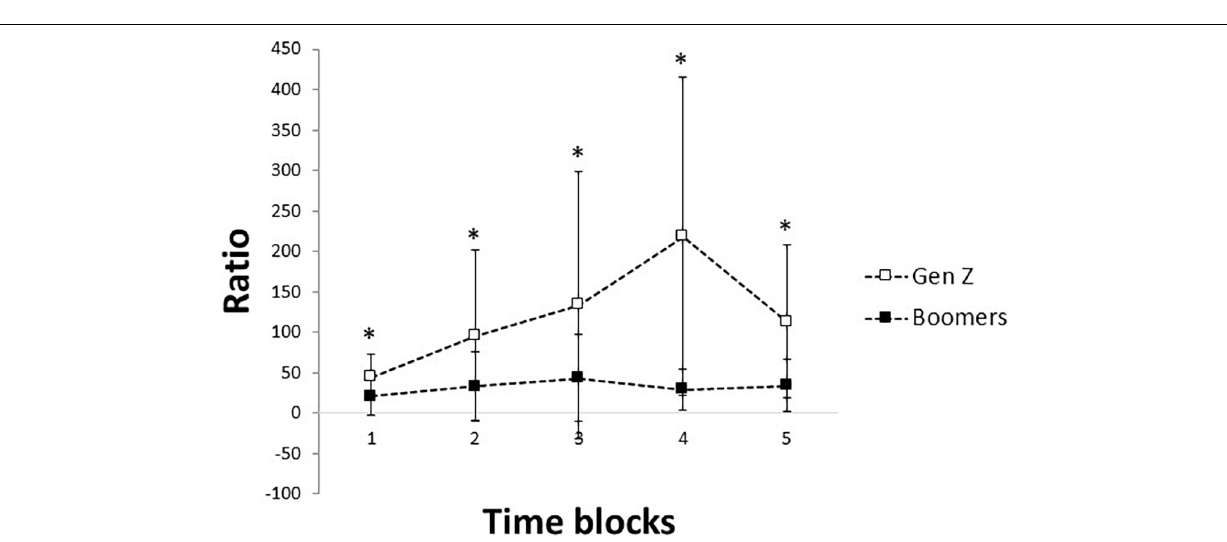
FIGURE 3 | Mean and standard deviation of the task efficiency (ratio of performance scores/game lives) across the five-time blocks in the Gen Z ( N = 16) and Baby Boomer age groups ( N = 16). Asterisks denote significant interactions between the groups and time blocks ( p <